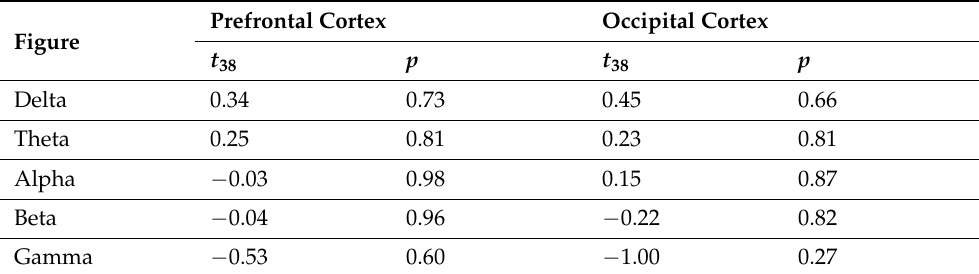
Figure 6. Averaged PSDs for the prefrontal and occipital cortex after the light stimulation. ( A ) shows averaged PSDs for the prefrontal ROI after the light stimulation. When comparing the PSD in the baseline EEG, EEG after 40 Hz-WL, and EEG after 40 Hz-VL conditions, there was no significant difference in any of the frequency bands; ( B ) shows averaged PSDs for the occipital ROI after the light stimulation. There was no significant difference in any of the frequency bands among the three conditions (i.e., baseline EEG, post-EEG with 40 Hz-WL, and post-EEG with 40 Hz-VL). The graphs are presented with ± S.D. shadows to the mean PSD for each condition. Table 3. Summary of statistical analysis results comparing averaged PSD for the prefrontal and occipital ROIs between post-EEG with 40 Hz-WL and post-EEG with 40 Hz-VL for each frequency band (* p <